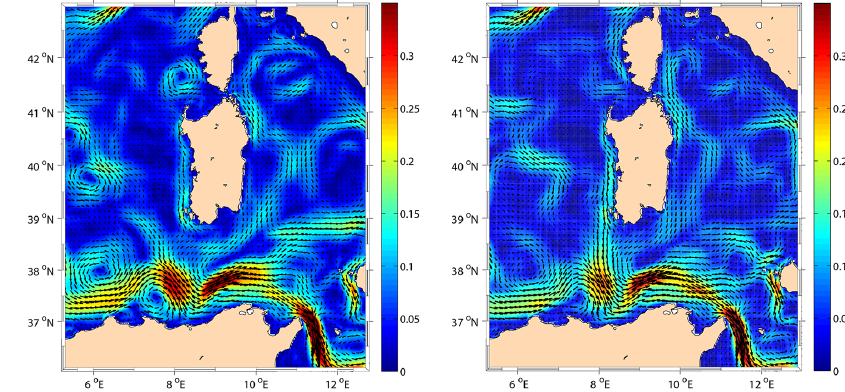
Figure 7. Mean flow for BF (left) and BFC experiments. Units are ms − 1 .